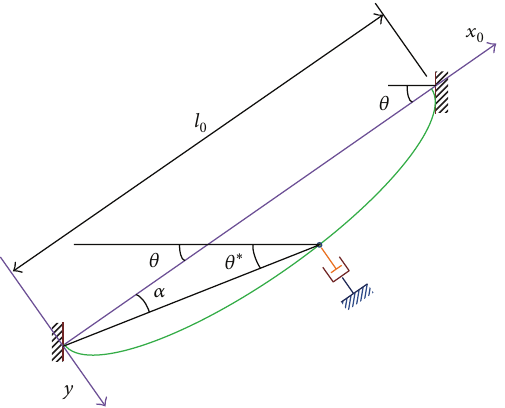
Figure 2: Geometry of acted positions of transverse